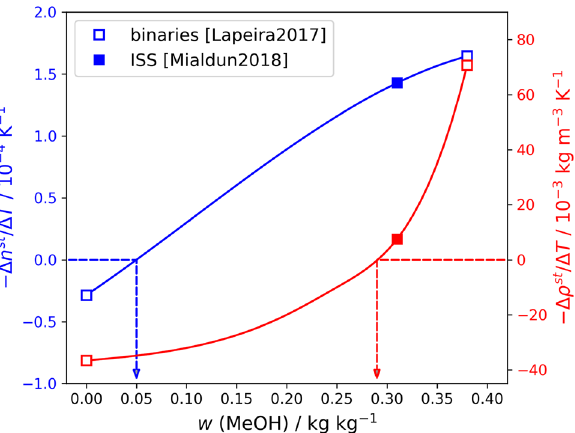
Figure 7. The separation in the ternary mixture Tol–MeOH–Ch along the path with toluene constant content, w Tol = 0.62 kg/kg, characterised by refractive index − � n st /� T (blue, left axis) and by density − �ρ st /� T (red, right